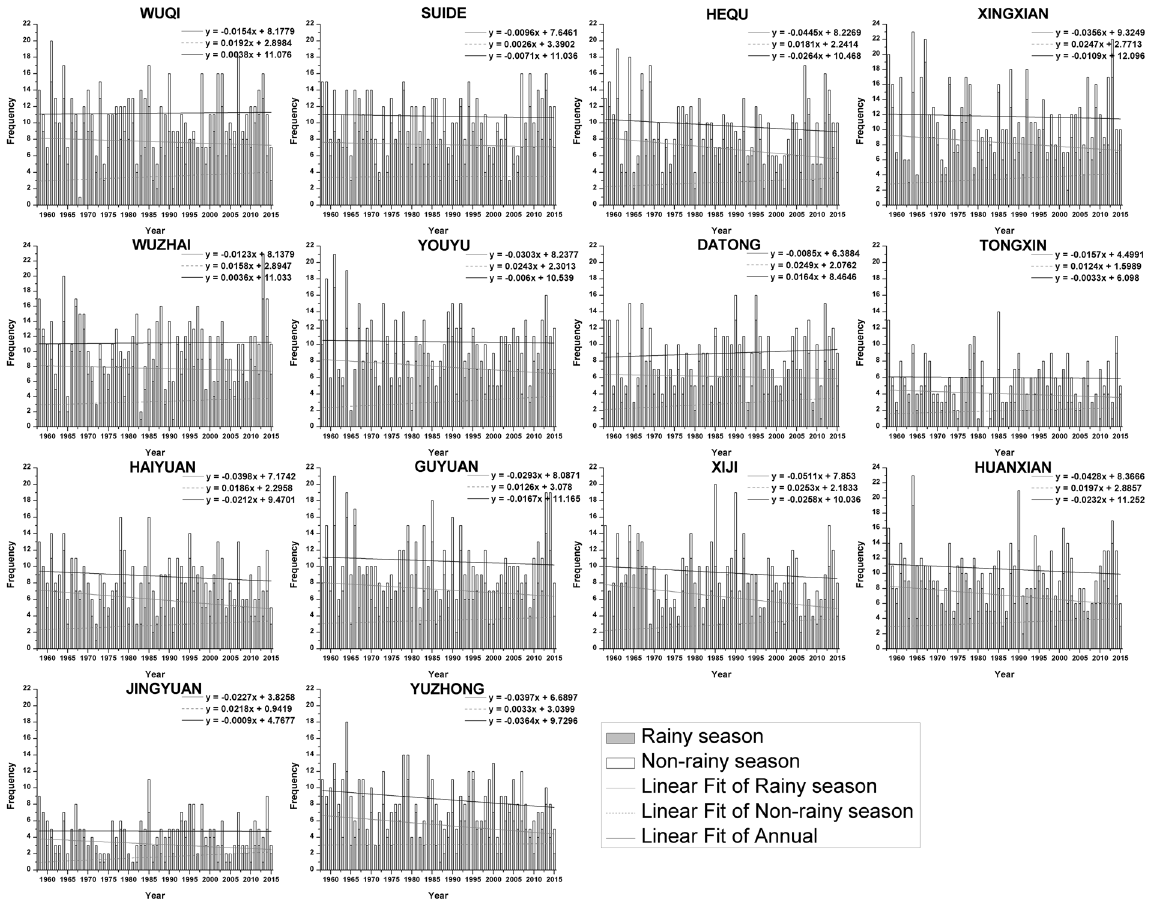
Figure 4. Frequency and trend of erosive rainfall in rainy season and non-rainy season.